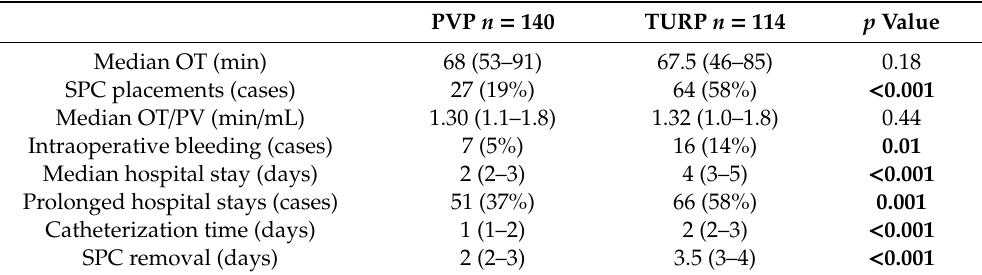
Table 2. Intraoperative and postoperative baseline